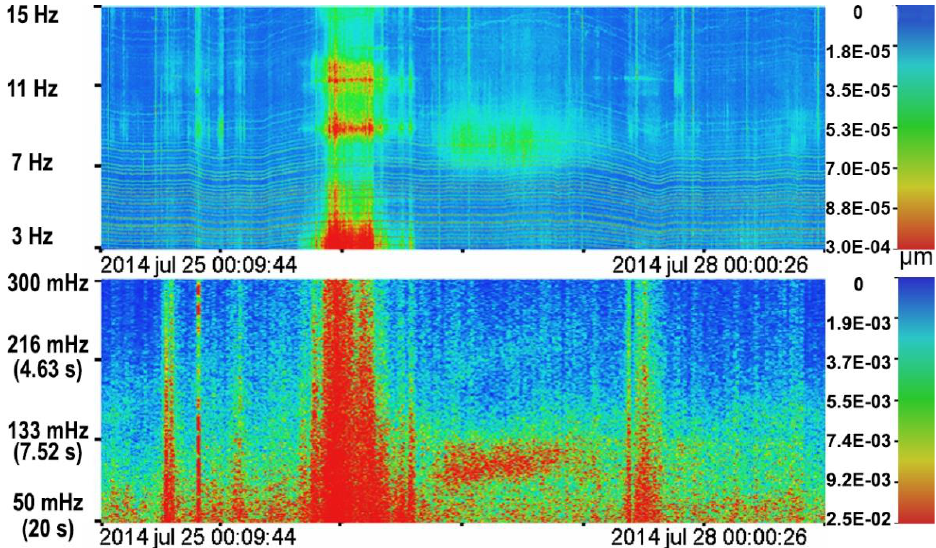
Figure 9. Dynamic spectrograms of laser strainmeter data during influence of Matmo typhoon.